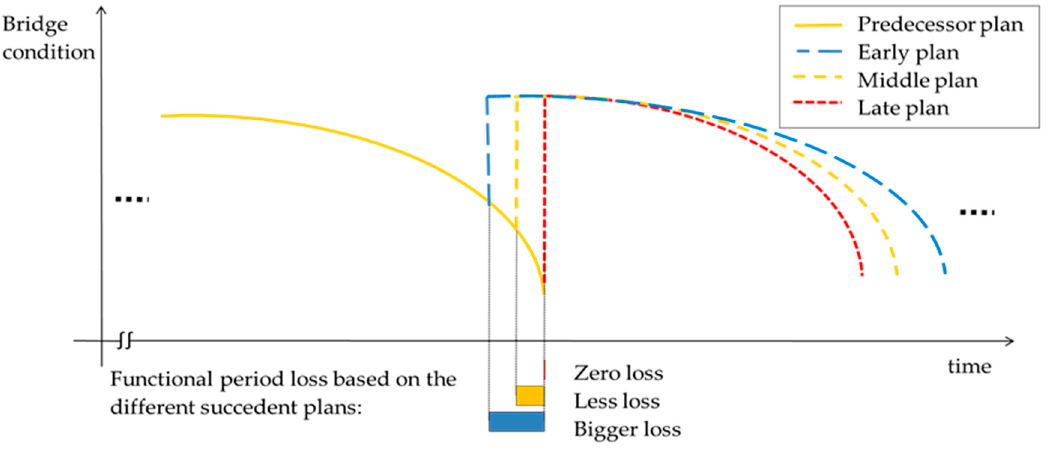
Figure 3. Impact of different plans on the leading plan.